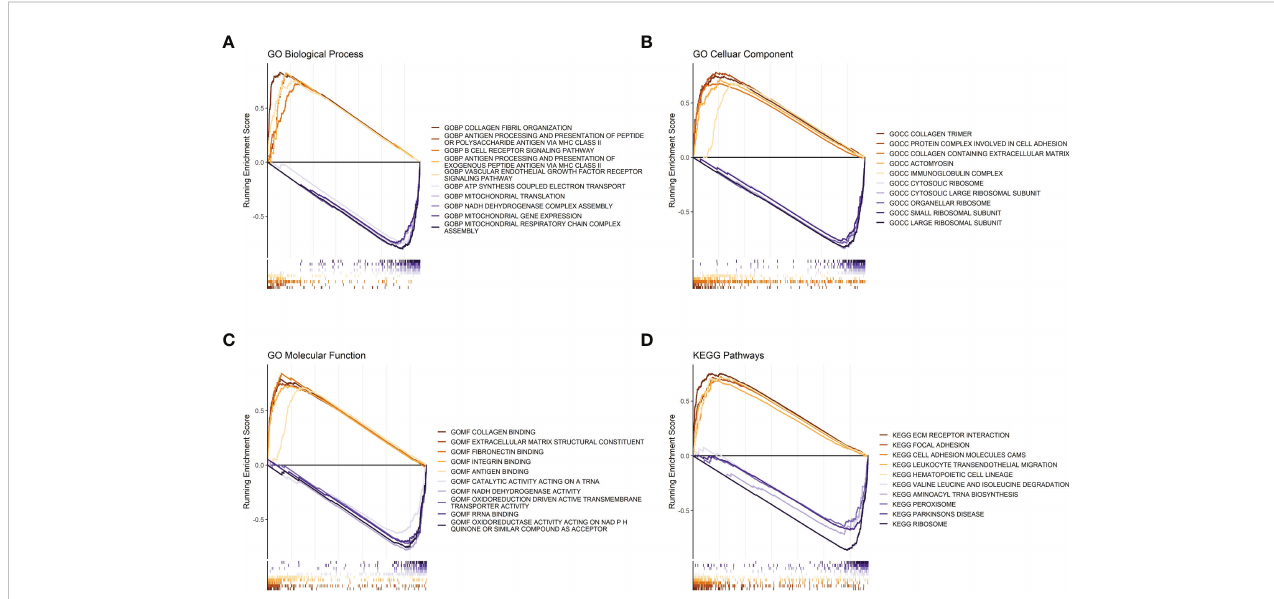
FIGURE 4 GSEA analysis between high- and low-risk groups. (A) Risk score GSEA: GO biological processes. (B) Risk score GSEA: GO cellular components. (C) Risk score GSEA: GO molecular functions. (D) Risk score GSEA: KEGG